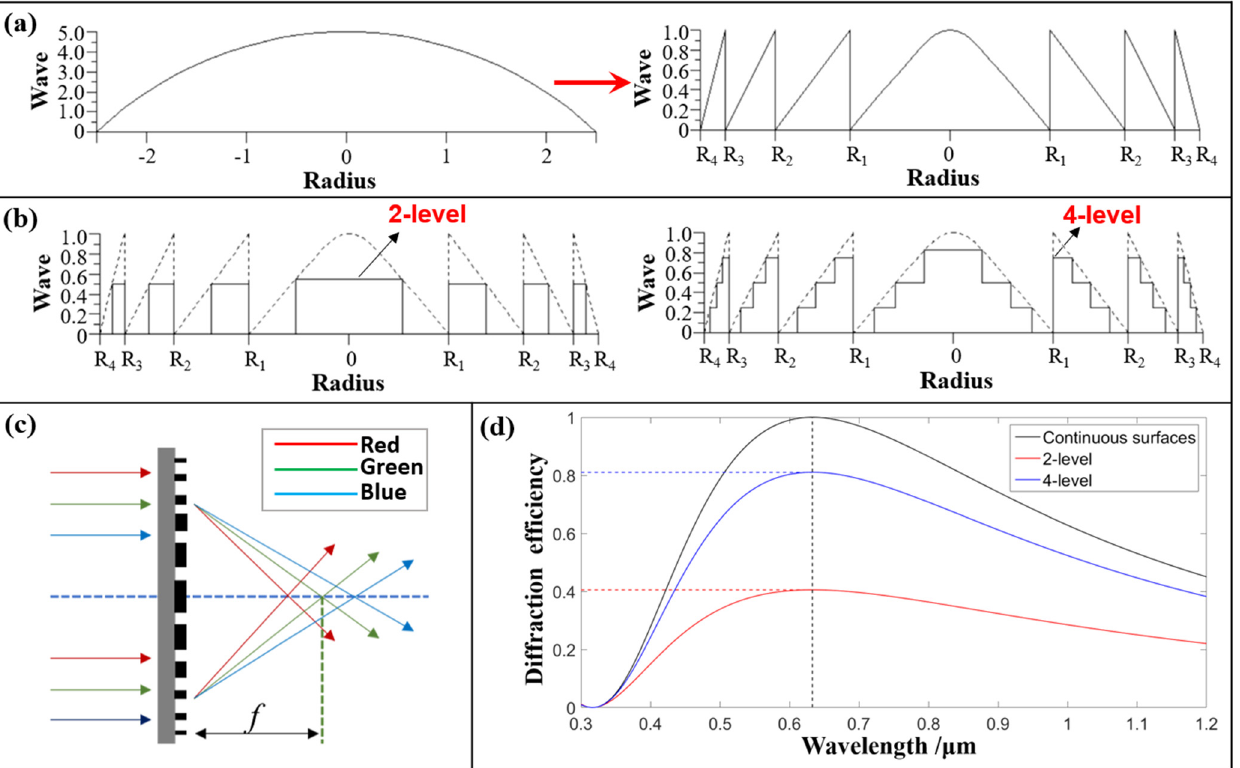
Figure 1. Imaging principle and optical property of FDL. ( a ) Origin and evolution of a diffractive lens. ( b ) Schematic diagrams of 2-level and 4-level microstructures. ( c ) Dispersion property. ( d ) Diffractive efficiency property.